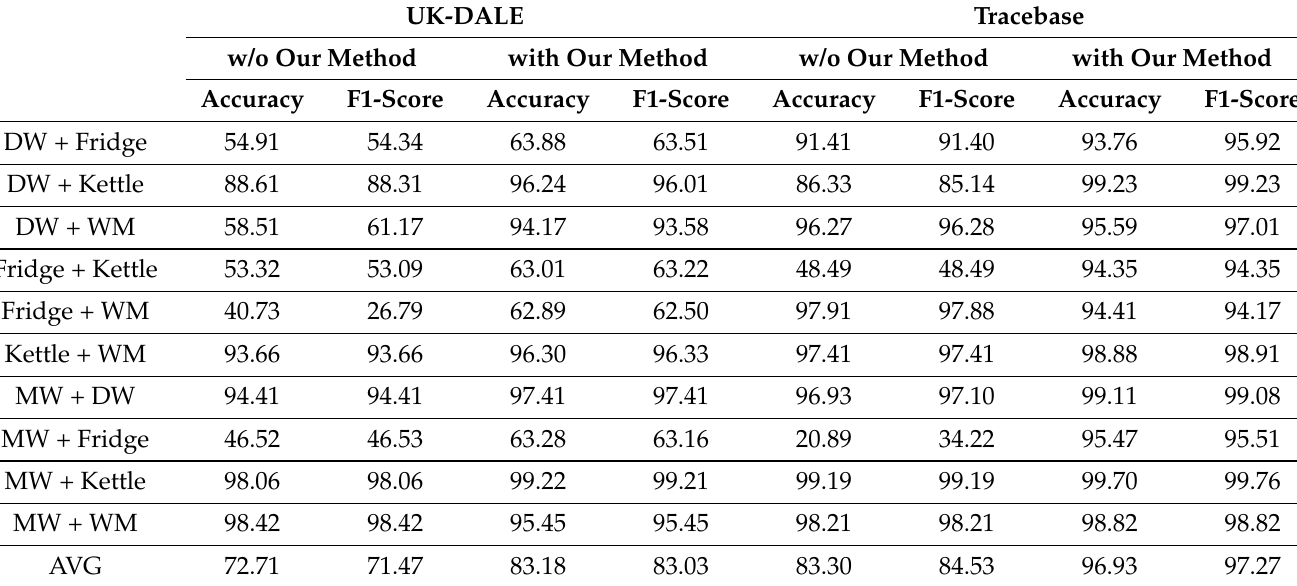
Table 6. The results of combinations of two appliances with